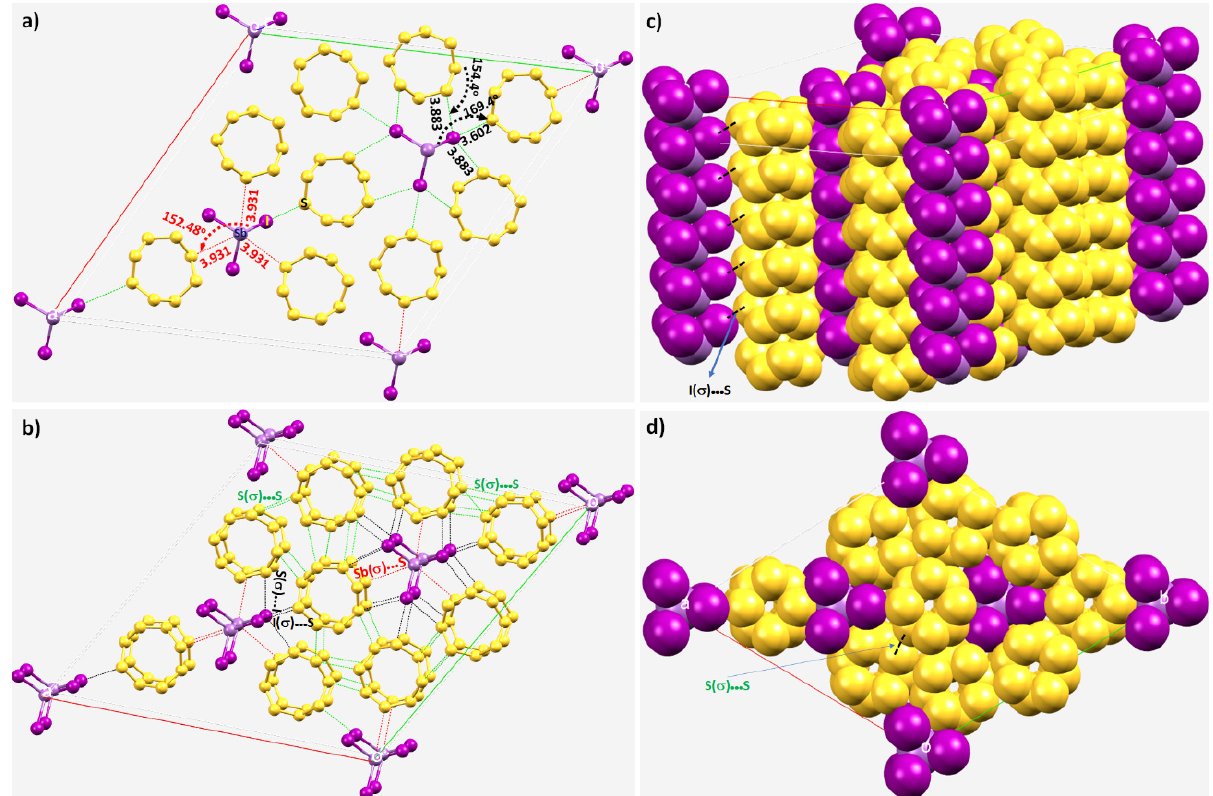
Figure 4. ( a ) The unit cell of the adduct between antimony triiodide and molecular sulfur, SbI 3 :3S 8 (ICSD ref. code. 14200). ( b ) Illustration of the 1 × 1 × 2 supercell structure of the adduct, showing the network of various intermolecular interactions involved in the formation of the crystalline material. ( c , d ) The side and top views of the nature of the packing in the SbI 3 :3S 8 crystal. Selected bond lengths and bond angles are in Å and degree, respectively. Dotted lines represent intermolecular interactions. Atom type is marked in ( a ).